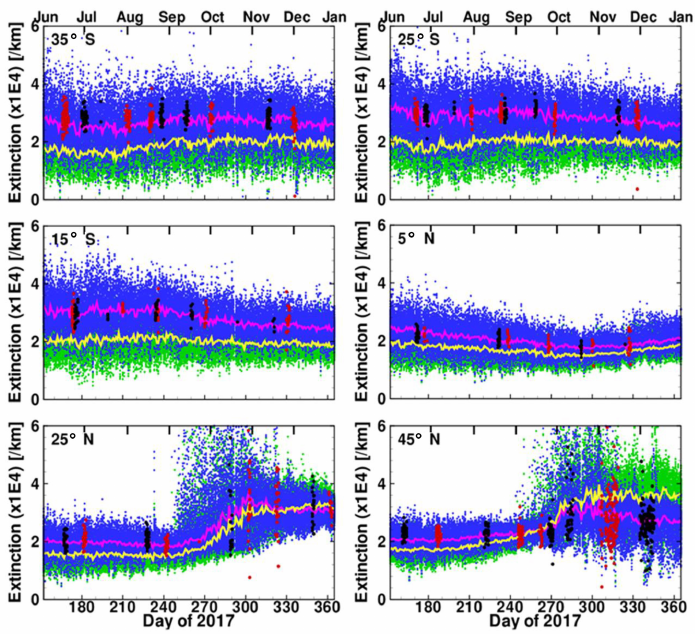
Figure 10. Time series of individual extinctions at 20.5km observed by LP V1.5 (blue), V1.0 (green), SAGE sunrises (red) and SAGE sunsets (black) for six different ± 5 ◦ latitude bins centered at 45 ◦ S, 25 ◦ S, 5 ◦ S, 5 ◦ N, 25 ◦ N and 45 ◦ N during the comparison period. The pink and yellow lines show the median of aerosol extinctions at 20.5km from LP V1.5 and V1.0,